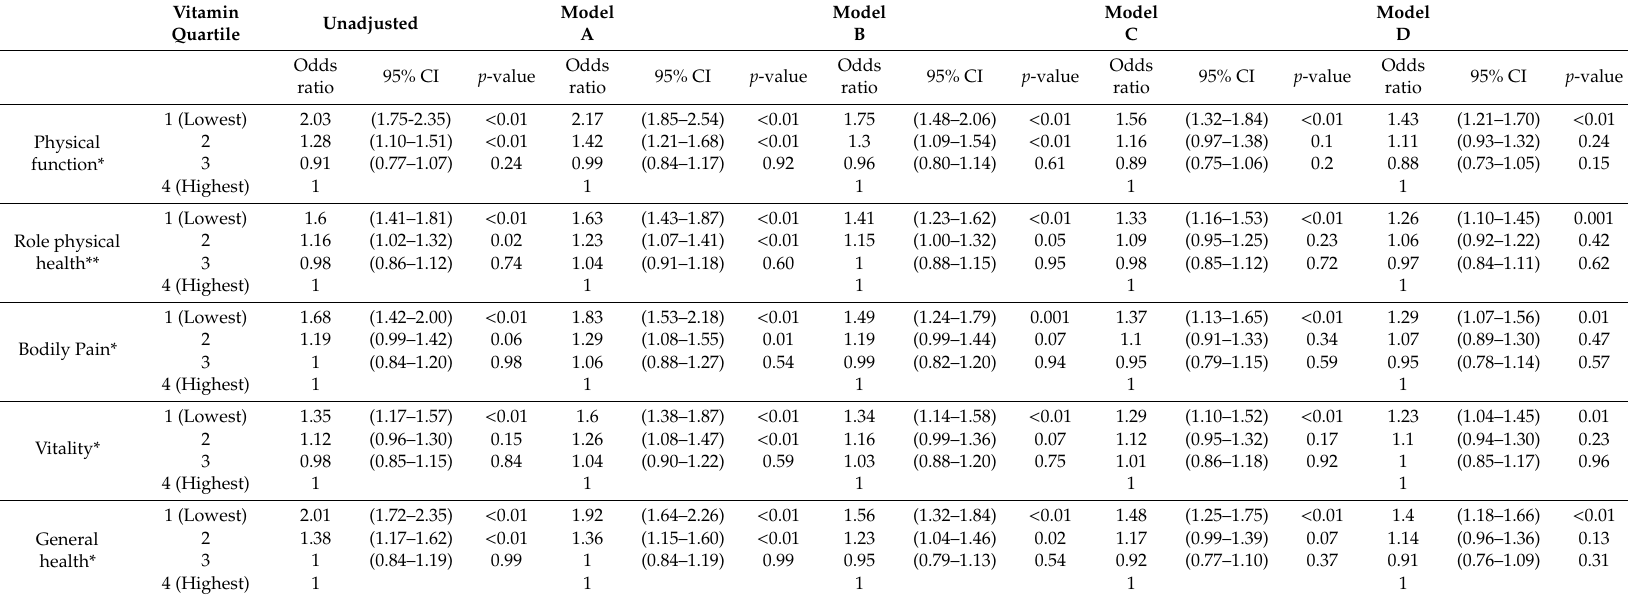
Table 3. Association between plasma vitamin C quartile and SF-36 domain (physical functions and